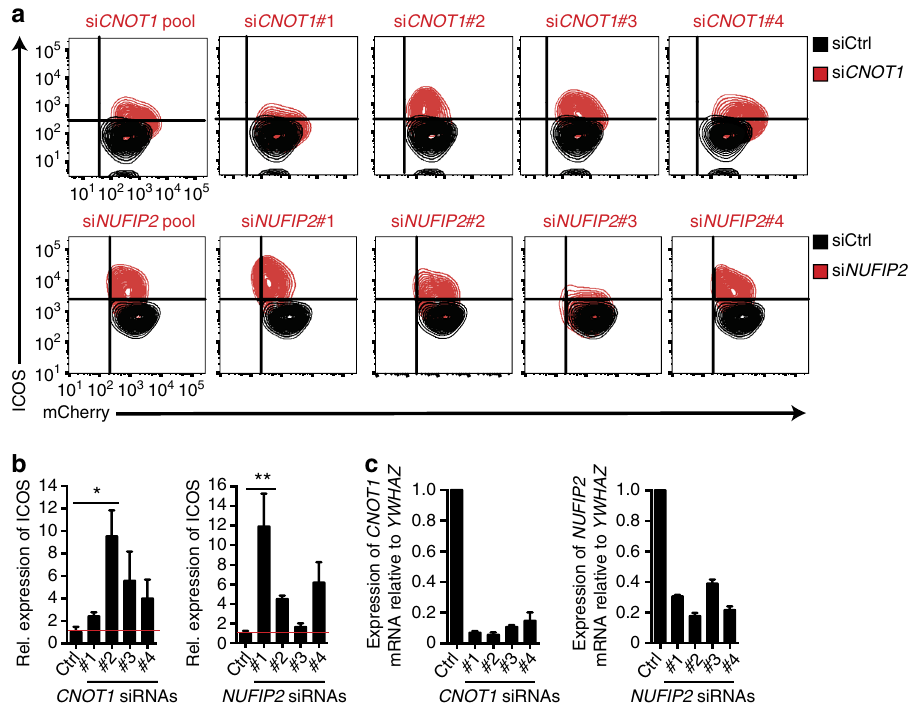
Fig. 2 Deconvolution of siRNA pools to validate genuine hits. a Flow cytometry analysis of ICOS and mCherry expression in HeLa reporter cells treated with individual or pooled CNOT1 or NUFIP2 siRNAs (red) or non-targeting control siRNAs (siCtrl) (black). Prior to analysis, cells were treated with doxycycline for 18 h to induce Roquin-1 overexpression. b Quanti fi ed ICOS MFI of cells shown in a . Expression levels were normalized to siCtrl-treated cells. c qPCR analysis of CNOT1 or NUFIP2 mRNA expression in cells from a . Expression was calculated relative to the reference gene YWHAZ and normalized to siCtrl- treated cells. Error bars in b and c represent mean and SD of three independent experiments. In a representatives of three independent experiments are shown. Statistical signi fi cance in b was calculated with one-way ANOVA Kruskal − Wallis test followed by Dunn ’ s multiple comparisons test (* p < 0.05, ** p <